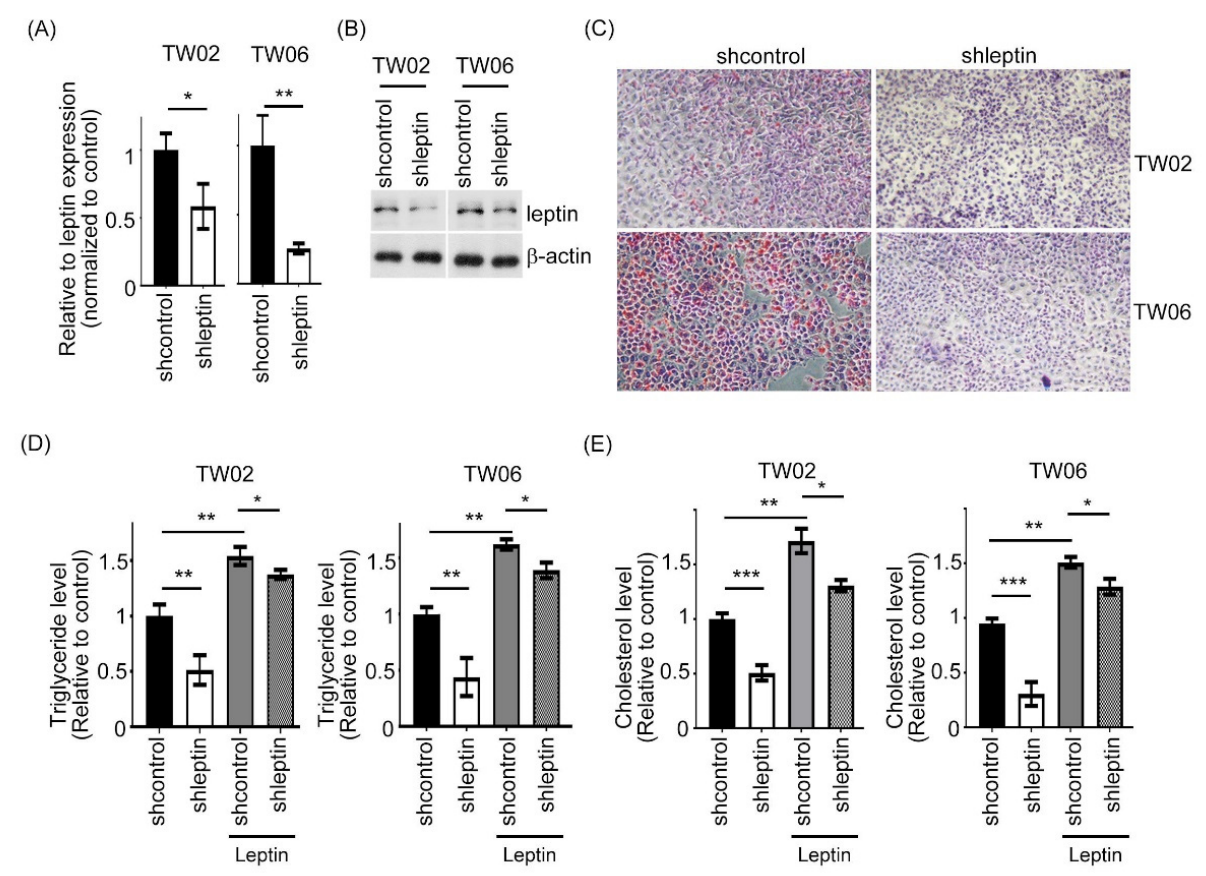
Figure 1. The effects of leptin on lipid accumulation and TG content in NPC cells. ( A , B ) The mRNA and protein levels of leptin were examined in leptin-depleted TW02 and TW06 cells and their corresponding control cells by QPCR and Western blotting. ( C ) The lipid accumulation was measured in leptin-depleted NPC cells. The intracellular TG content ( D ) and cholesterol content ( E ) in leptin- depleted NPC cells and negative control cells were investigated in the presence or absence of leptin (10 nM) stimulation. All data were obtained from three independent experiments. Data are presented as the mean ± SD. *: p < 0.05; **: p < 0.01; ***: p < 0.001.